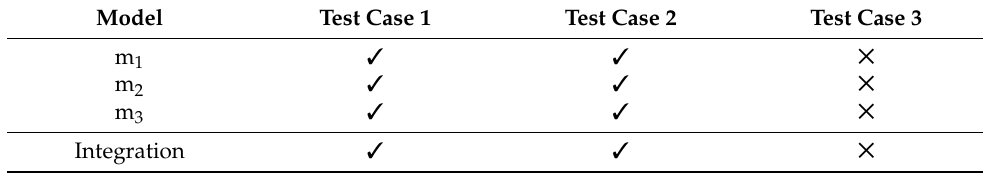
Table 3. Integration does not